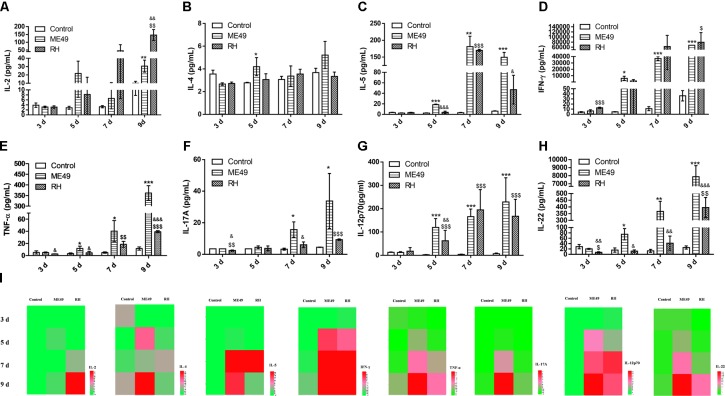
Cytokine production during infection with T. gondii of the RH or ME49 strain. (A–H) Comparisons of cytokine levels (IL-2, IL-4, IL-5, IFN-γ, TNF-α, IL-17A, IL-12p70, and IL-22) in sera from Control, ME49, and RH groups. (I) Heatmaps directly showing the difference in the cytokines detected. The results are representative of three independent experiments with 3–5 mice per group per experiment; data are the means ± SDs. ∗,$,&P < 0.05, ∗∗,$$,&&P < 0.01, ∗∗∗,$$$,&&&P < 0.001; ∗indicates ME49 group comparisons to the control group, $indicates RH group comparisons to the control group, &indicates RH group comparisons to the ME49 group.